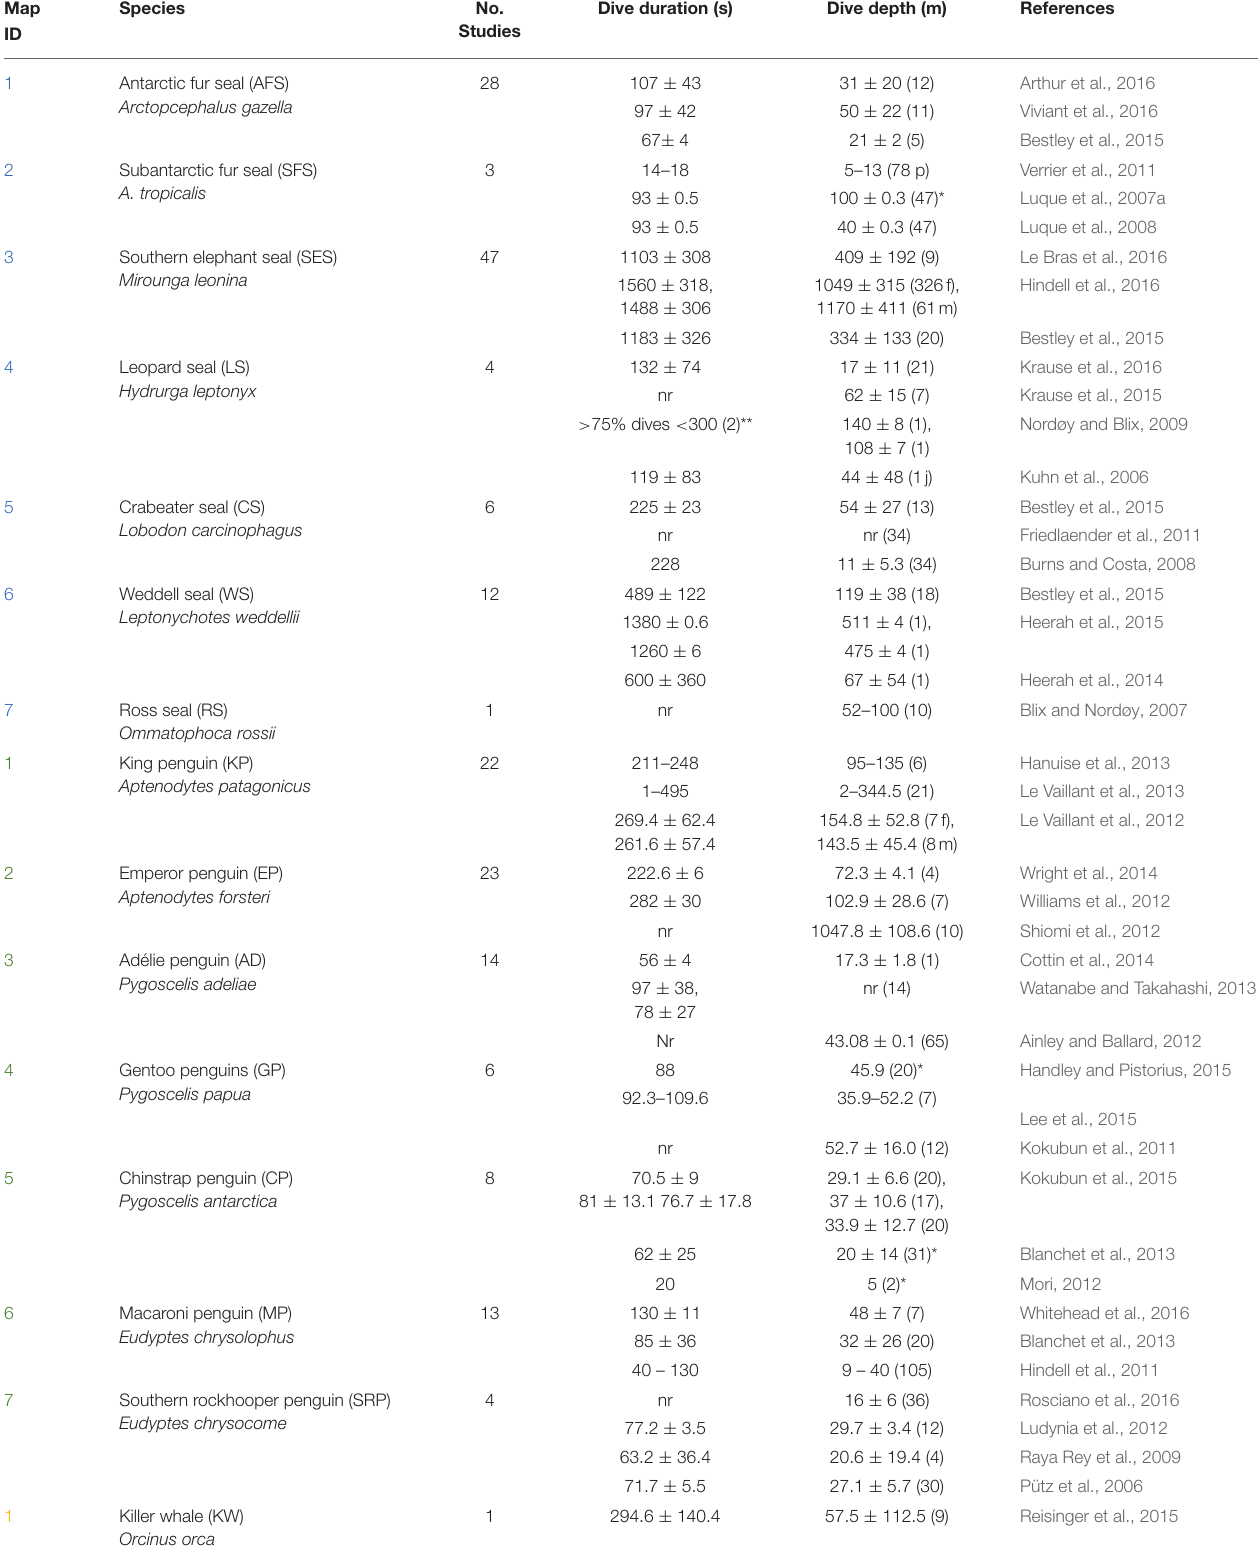
TABLE 2 | Southern Ocean literature review results showing the number of studies conducted by species from 2006–2016.